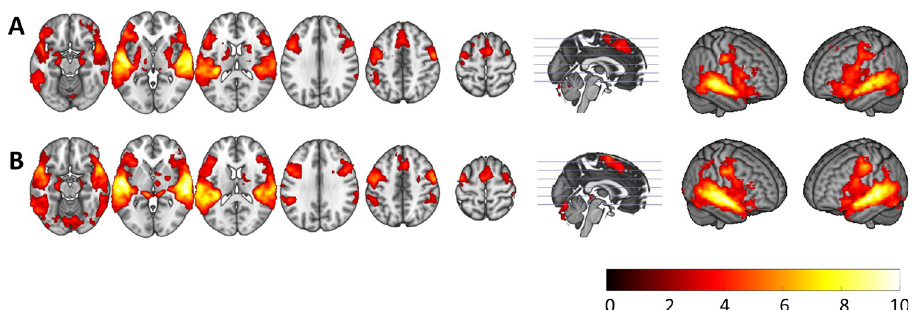
Fig 1. Activation maps for the words condition in healthy controls (A) and patients with schizophrenia (B). Colour bar depicts Z